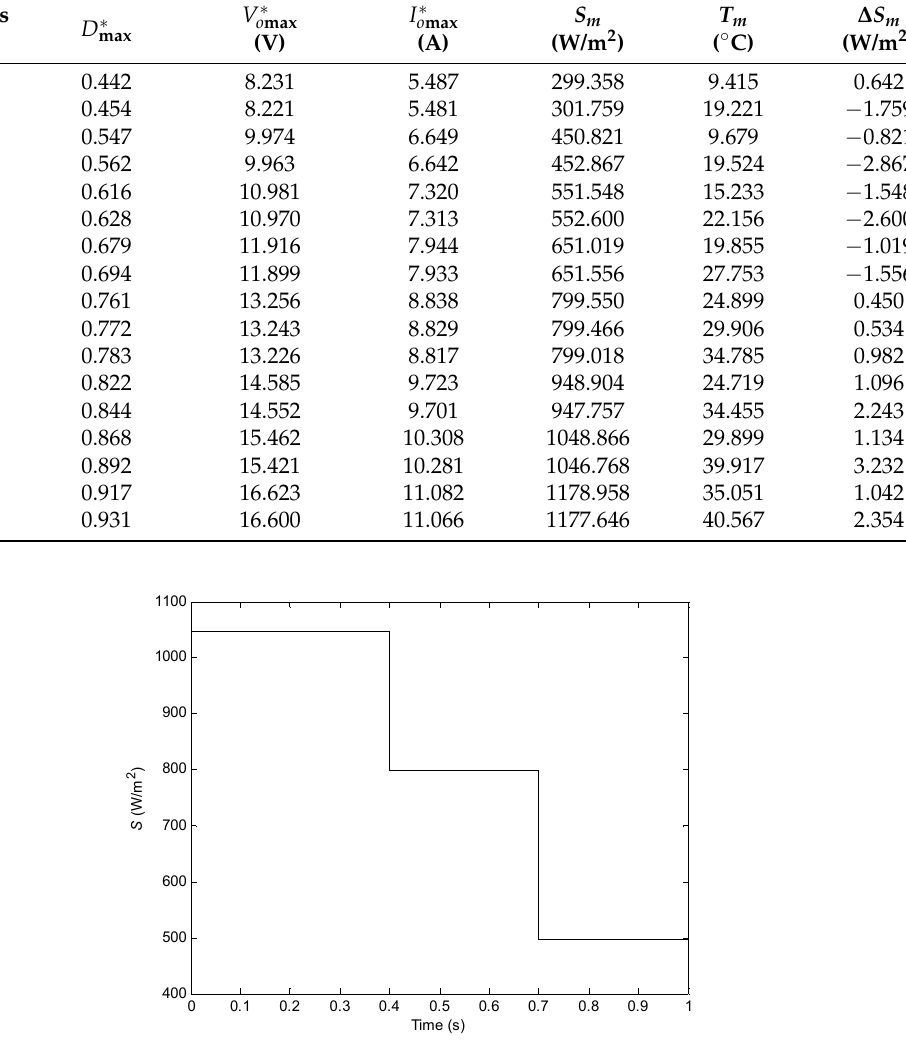
Figure 13. Curve in first simulation. Figure 14. Curve in first simulation.